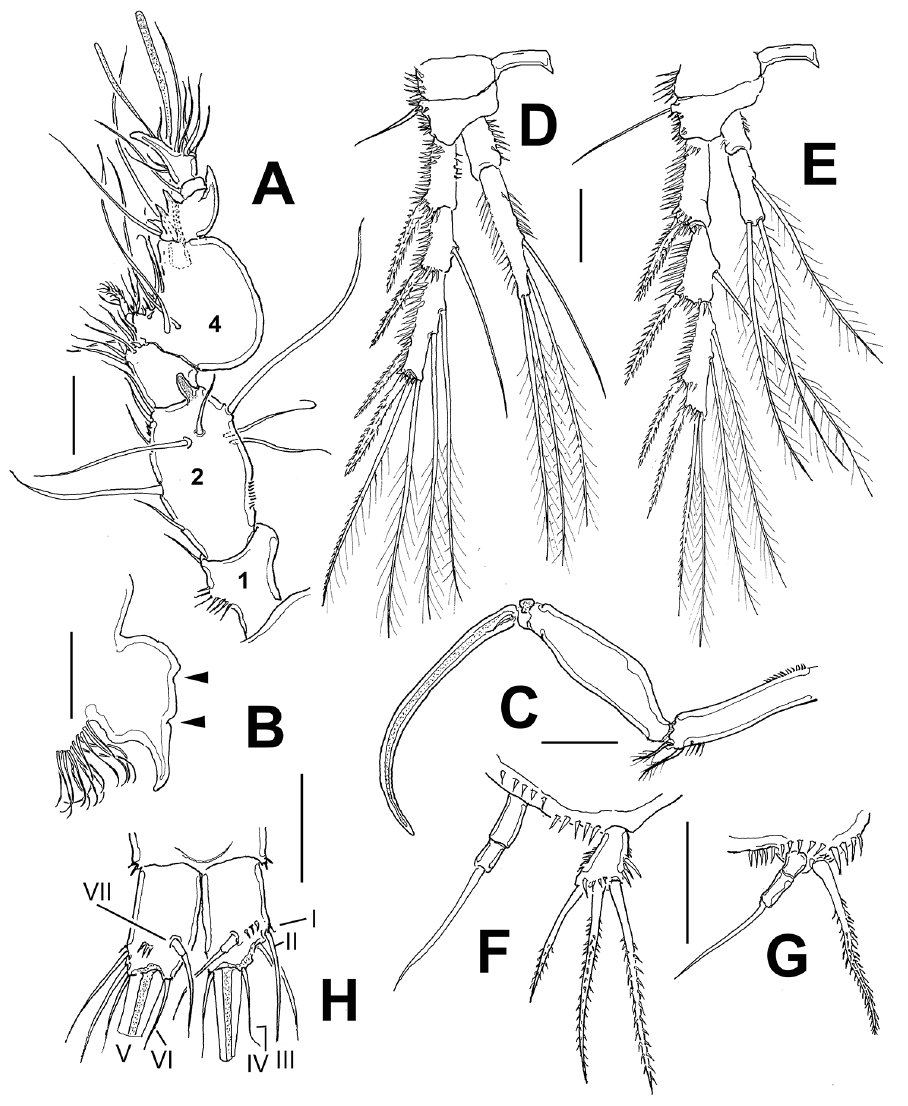
Figure 4. Echinolaophonte villabonae sp. n., allotype male from Colombia. A antennule B cephalosome dorsal process, lateral view, arrows indicate notches C maxilliped D leg 3 E leg 4 F leg 5 G leg 6 H caudal rami showing setae I-VII, dorsal view. Scale bars: 25 μm ( A–G ), 50 μm ( H ). P4 (Fig. 4E) as in female except for EXP3 and outer spine on EXP1-2,